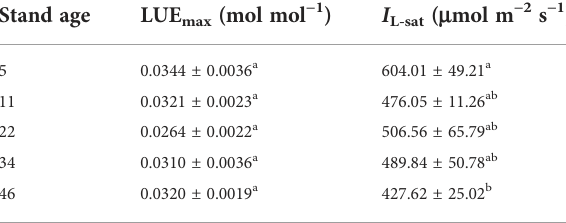
TABLE 4 The maximum light use ef fi ciency and saturation irradiance for Haloxylon ammodendron at different stand ages. Stand